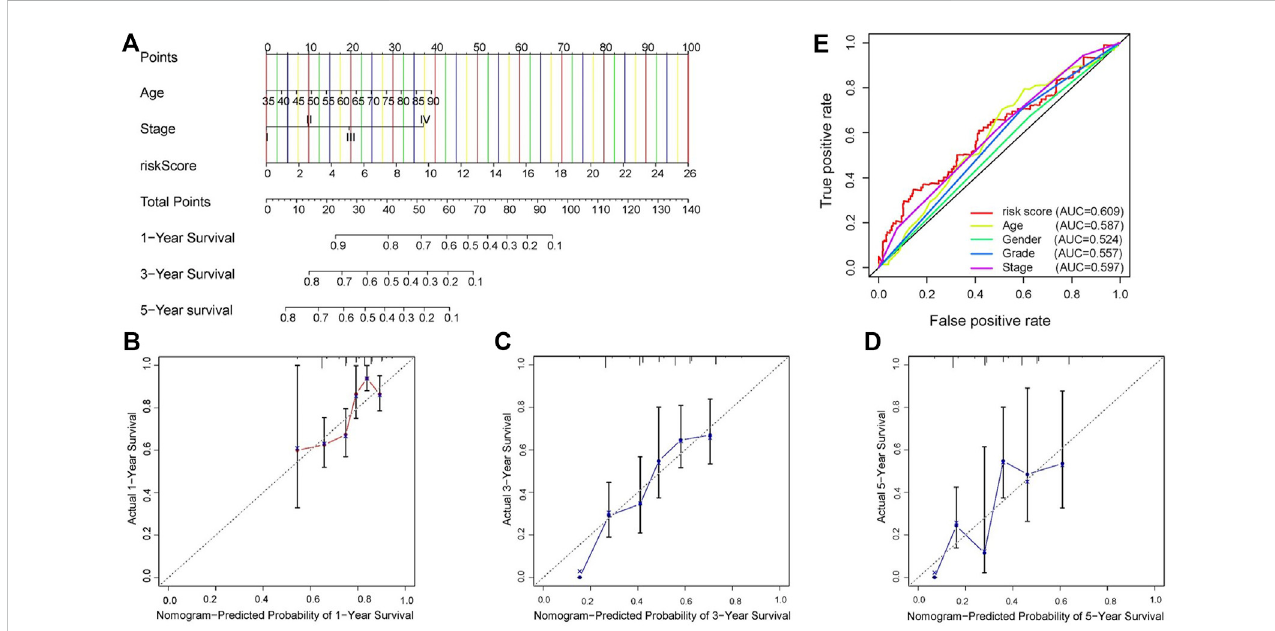
FIGURE 6 Construction of signature-based predictions. (A) Nomogram employed to predict 1-, 3-, and 5-year OS in GC patients. (B – D) Calibration curves representingtherelationshipbetweennomogrampredictedsurvivalprobabilityandactualsurvivalprobability. (E) ROCcurveandAUCvaluesofsignatureand clinicopathological factors.